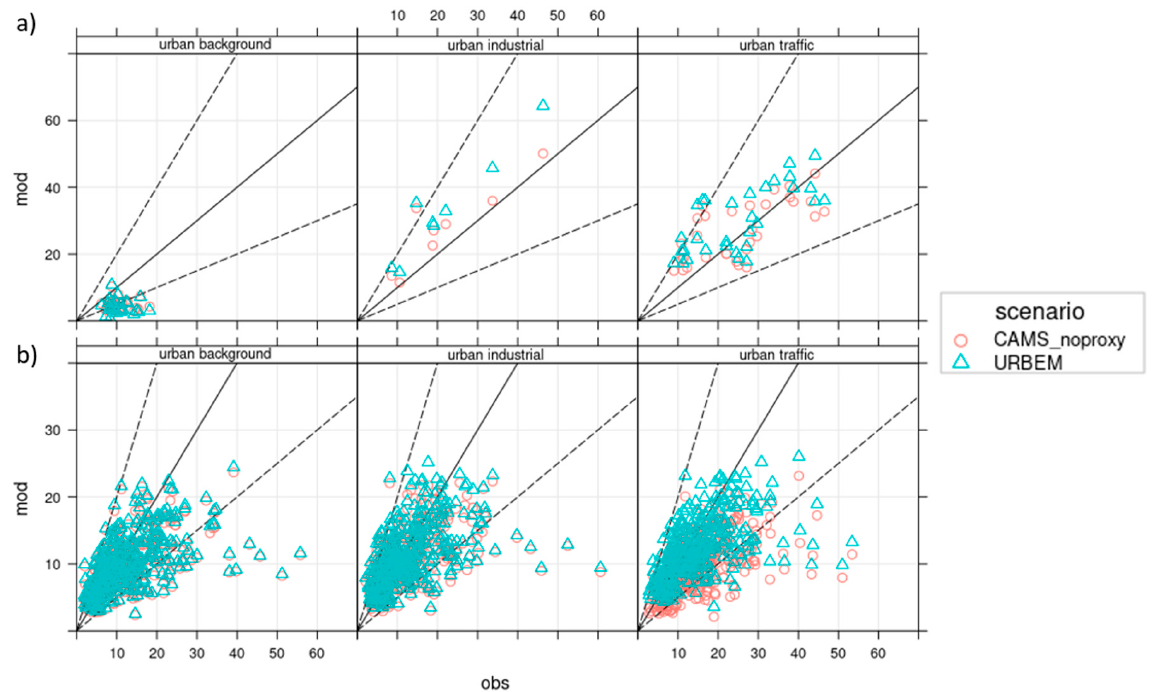
Figure A1. NH 3 emission fields from agriculture for Hamburg ( a , b ) and Athens ( c , d ), as originally provided by CAMS (left) and as produced by the UrbEm framework (right). Symbols and isopleths of the main proxies used per source type for the spatial disaggregation of CAMS toward the 1 km by 1 km grid are shown on the maps of the right column (UrbEm outputs).